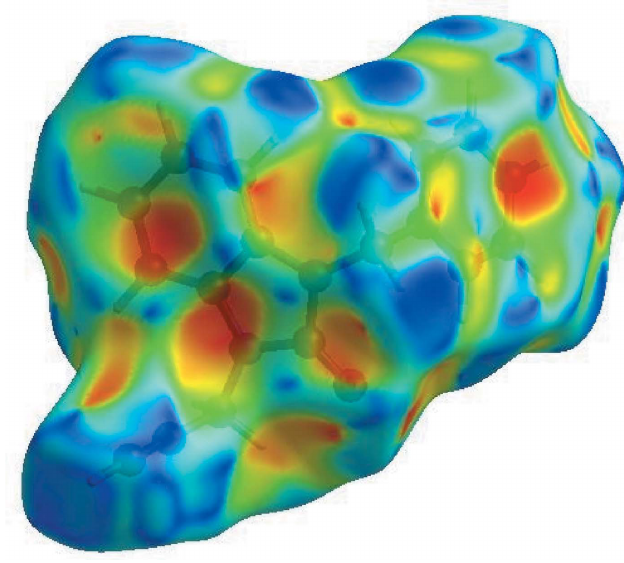
Figure 6 Hirshfeld surface of the title compound plotted over